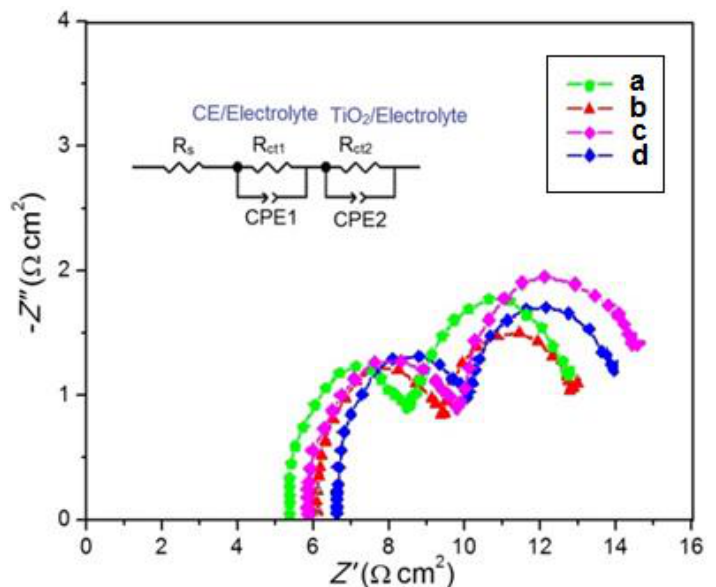
Figure 7. Nyquist plots of the PVA/PPy/KI/I 2 electrolyte with various plasticizers (in wt.%); ( a ) EC, ( b ) PC, ( c ) GBL, and ( d ) DBP. Table 4. EIS parameters for the PVA/PPy/KI/I 2 electrolyte with various plasticizers.